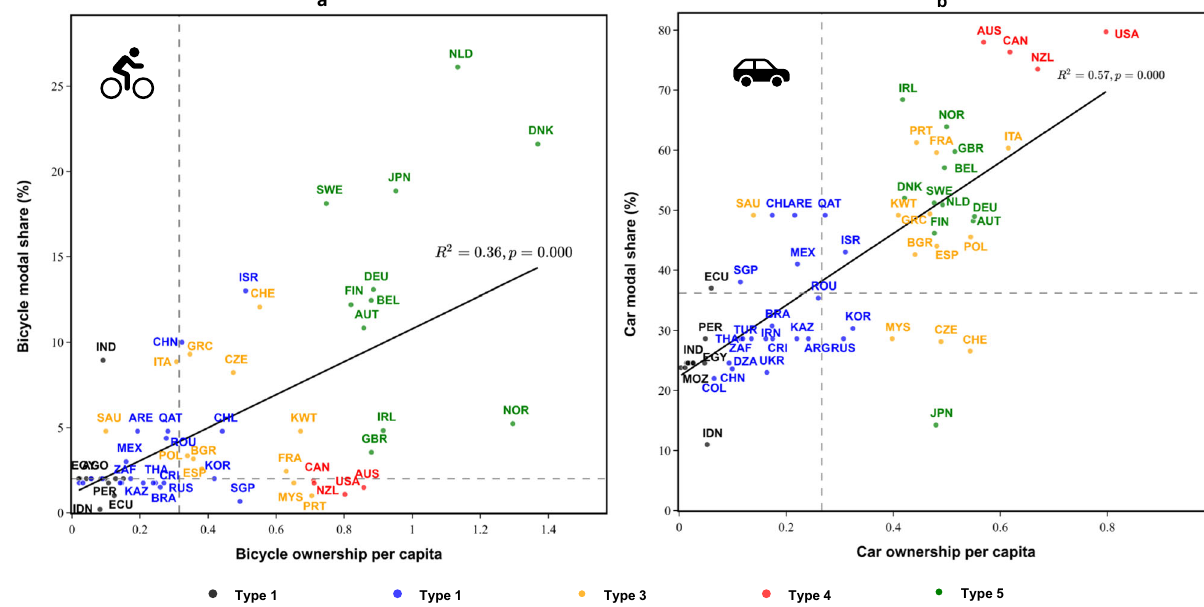
Fig. 3 The patterns of the car and bicycle use in 2015. a Bicycle modal share against bicycle ownership per capita, and b car modal share against car ownership per capita. The dashed lines indicate the median values of the x-axis and y-axis, which splits the fi gures into four quadrants. The solid lines in a and b show results of the linear regression fi tting. See details of regression results in Supplementary Table 9 and Supplementary Table